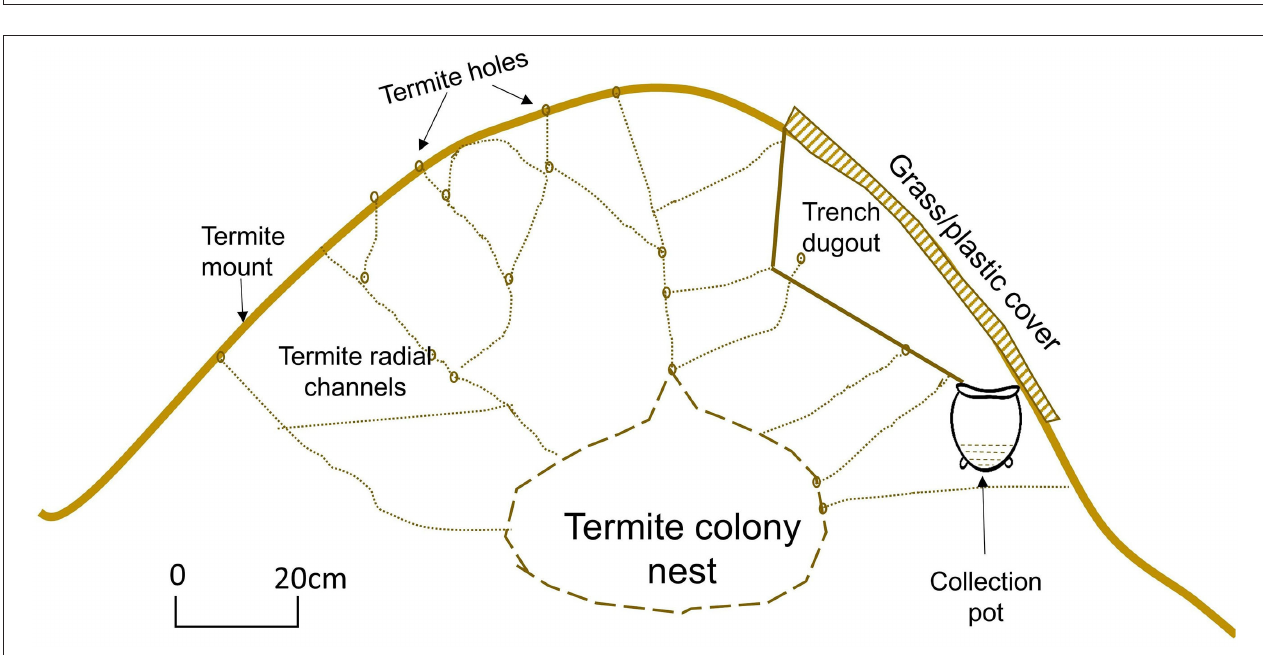
FIGURE 2 | Traditional light trap used to selectively harvest the alate flying termites.